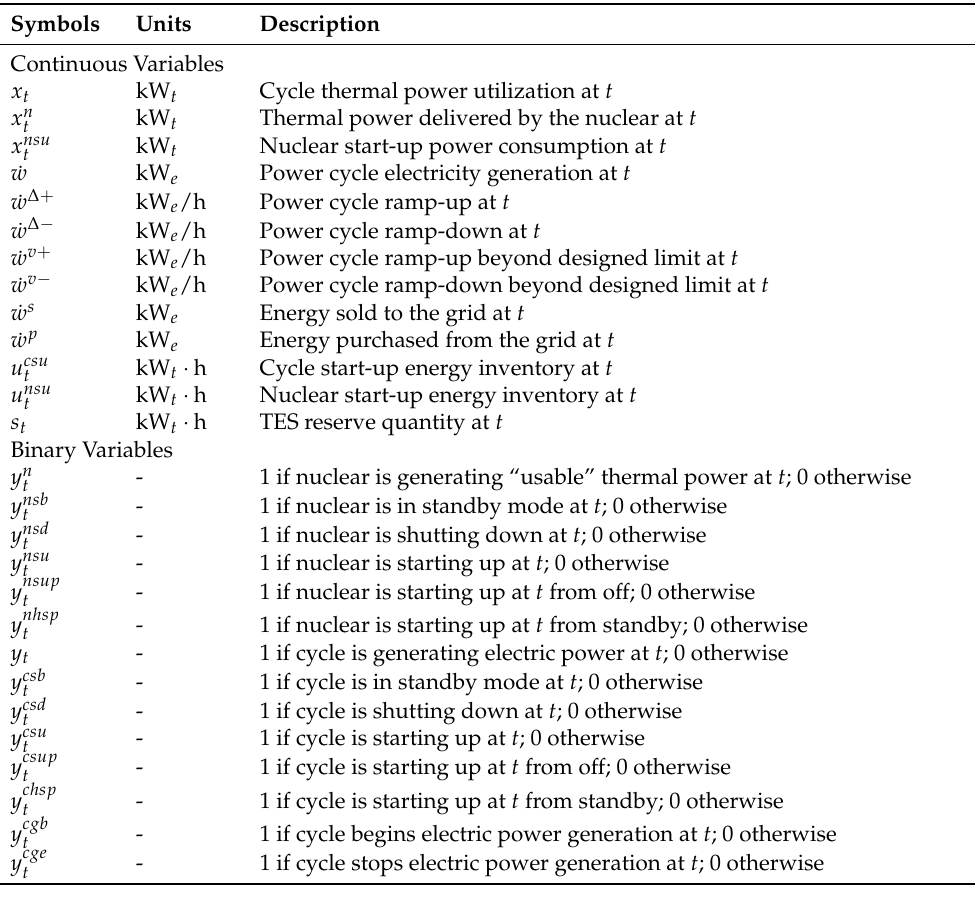
Table 3. Variables used in